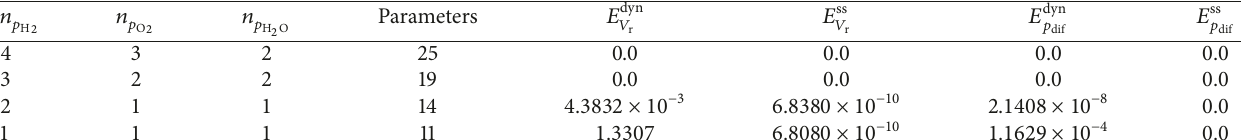
Table 15: Comparison of the ideal full-order model ( 𝑛 𝑝 algorithms in terms of the number of pressure parameters as well as the dynamic and steady-state errors for two process output variables (algorithm 2).